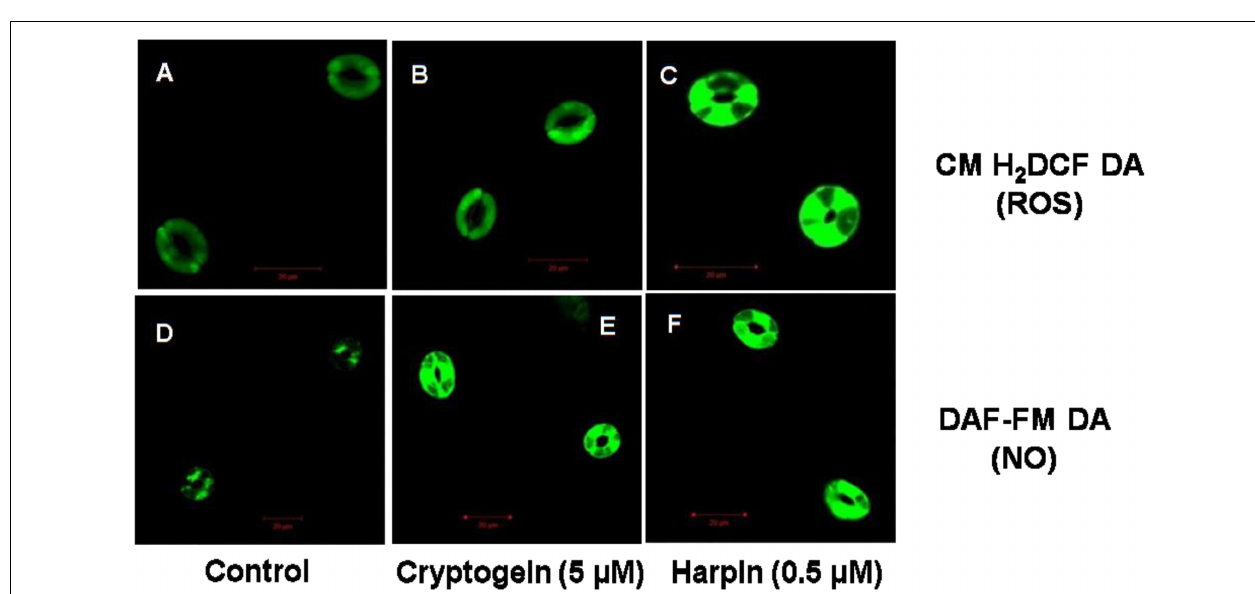
FIGURE 1 | Stomatal closure in response to varying concentrations of microbial elicitors, cryptogein and harpin in Arabidopsis thaliana . The two elicitors induced the stomatal closure in a concentration dependant manner and maximum closure was observed at 5 µ M of cryptogein (A) , 500 nM of harpin (B) . Averages of three different experiments from three different days with SE are plotted.